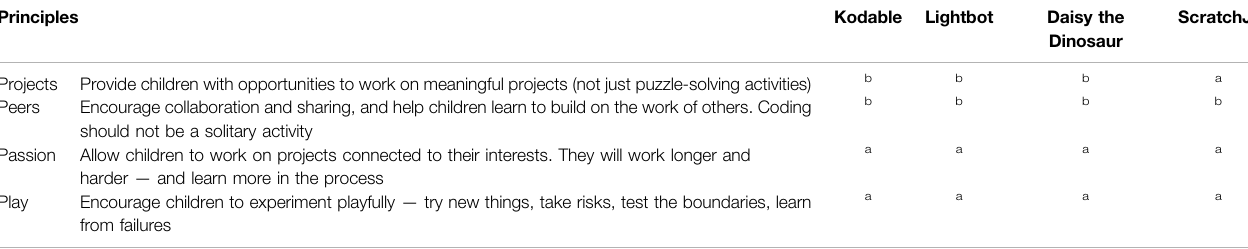
TABLE 4 | The computational fl uency principles supported in Kodable, Lightbot, Daisy the Dinosaur, and the ScratchJr.